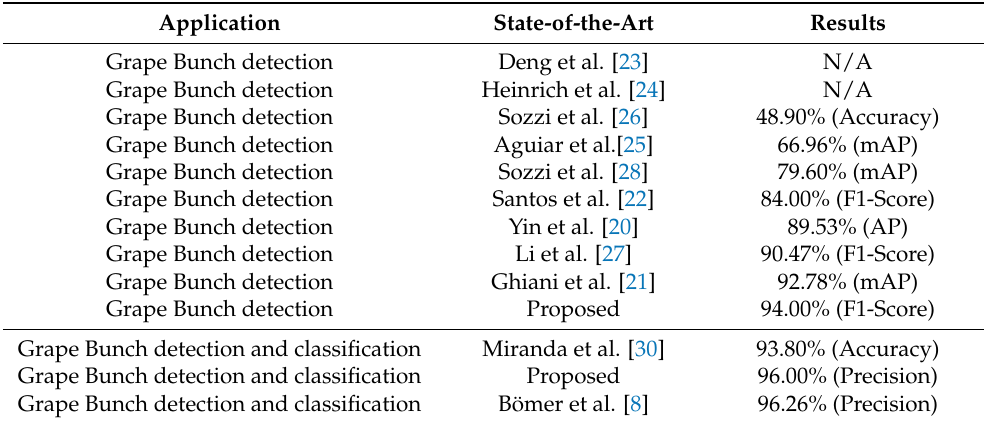
Table 10. Comparison between the proposed models and the state-of-the-art DL for grapevine bunch detection and classification based on the health